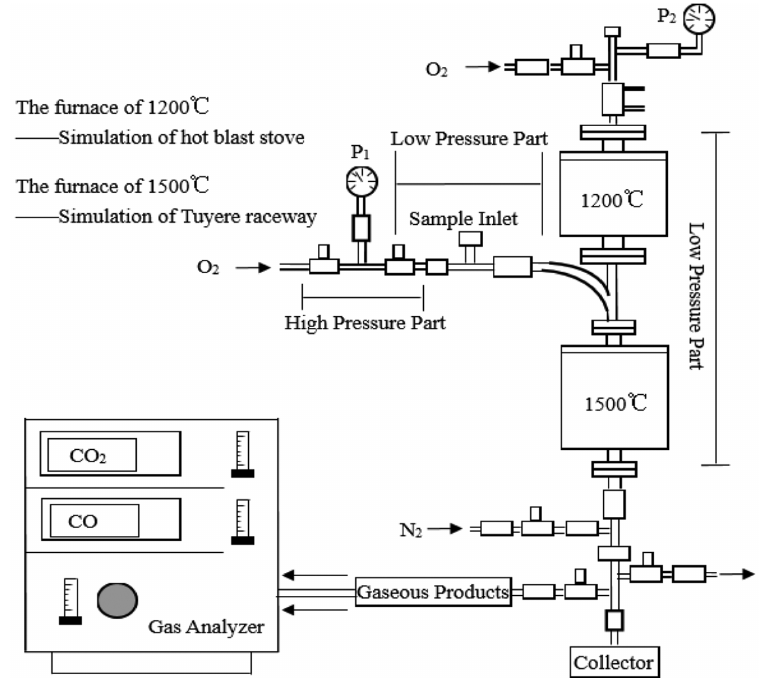
Figure 1: Schematic diagram of the New Experimental Equipment for Combustion